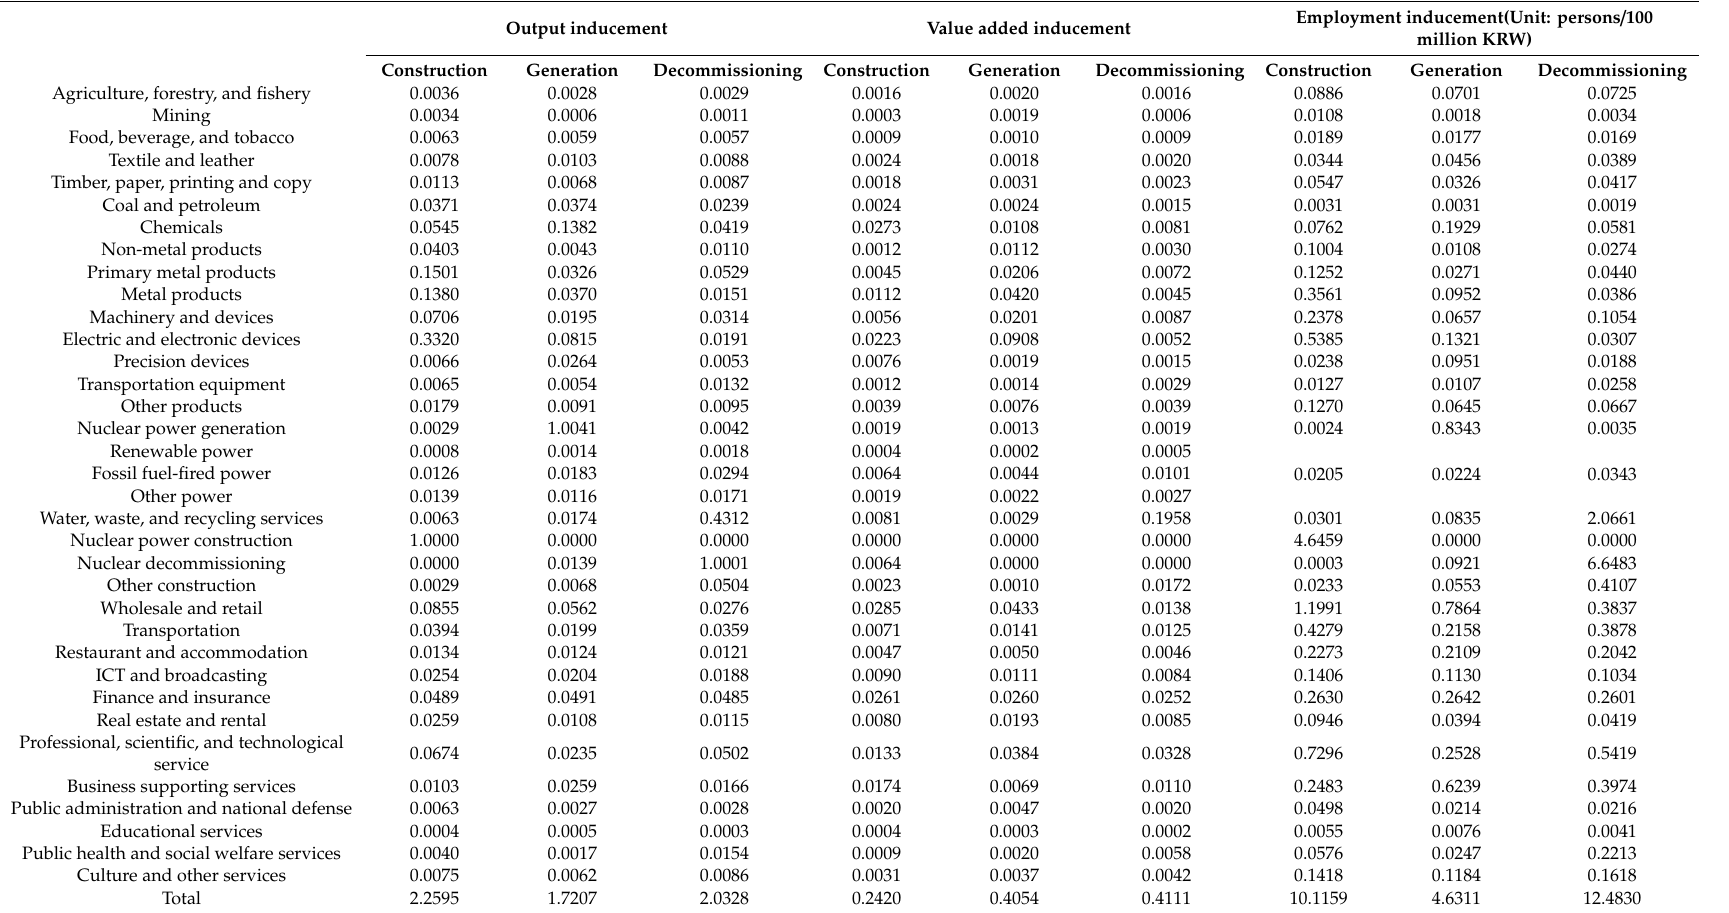
Table A3. Output, value added, and employment inducements of three nuclear industry